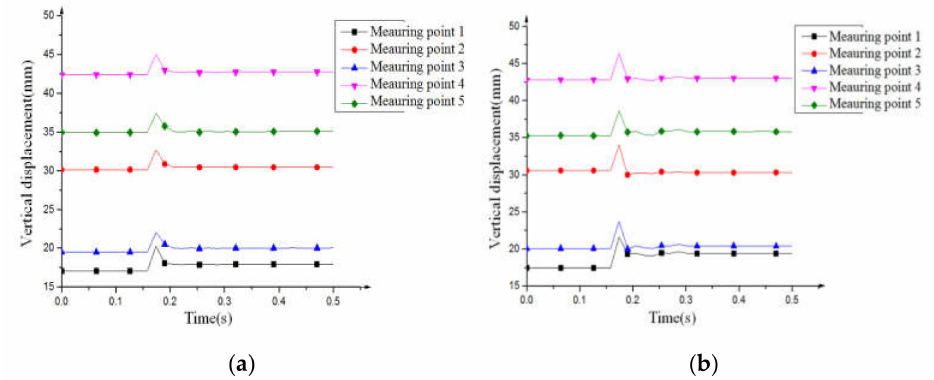
Figure 14. The displacement time-history curve of W4 specimen. ( a ) Impact at a height of 1 m; ( b ) Impact at a height of 1.5